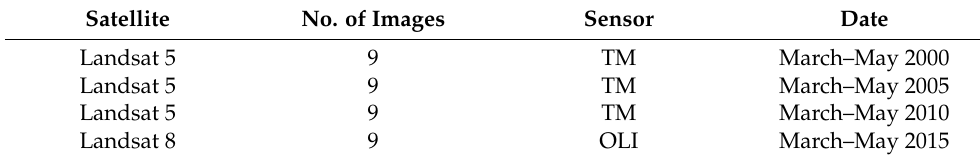
Table 1. Satellite imagery was used for remote sensing analysis. Satellite No. of Images